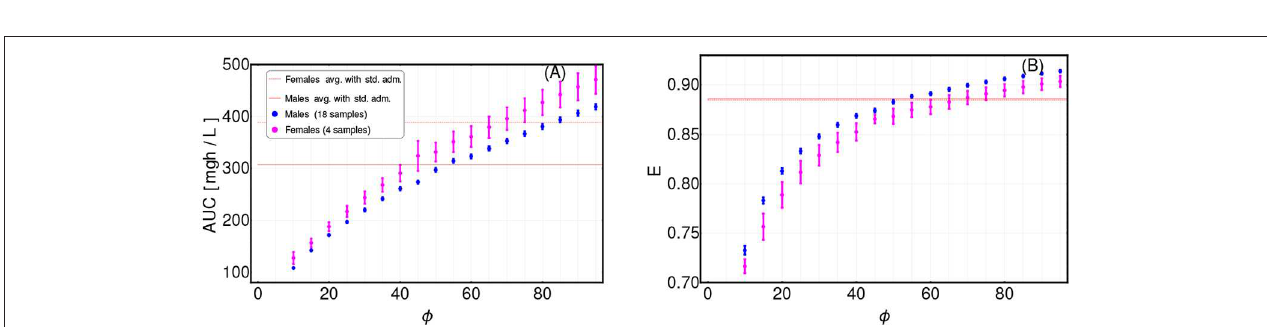
FIGURE 4 | Patient-specific PD models. (A) personalized PD curves obtained from Equation (10) by using E max = 1 and n = 1 for all patients, and distinct values of EC 50 , based on the death rate of cancer stem cells, as estimated from longitudinal data on tumor burden; x axis ( Log 10 scale) describes the concentration in the range C ∈ [0,1.2] [ mg / L ], on y axis the efficiency E is displayed. The solid blue curves correspond to the 18 distinct male patients included in the dataset and the solid pink curves correspond to the 4 distinct female patients and the dashed red curve represents the population-average pharmacodynamics. (B) Heat-map returning the variation of efficiency E , computed via Equation (10), with respect to distinct parameters of the PK model—i.e., patient-specific time-average concentration ¯ C (y axis)—and of the PD model—i.e., patient-specific EC 50 (x axis). Red triangles represent the 22 patients in the dataset.